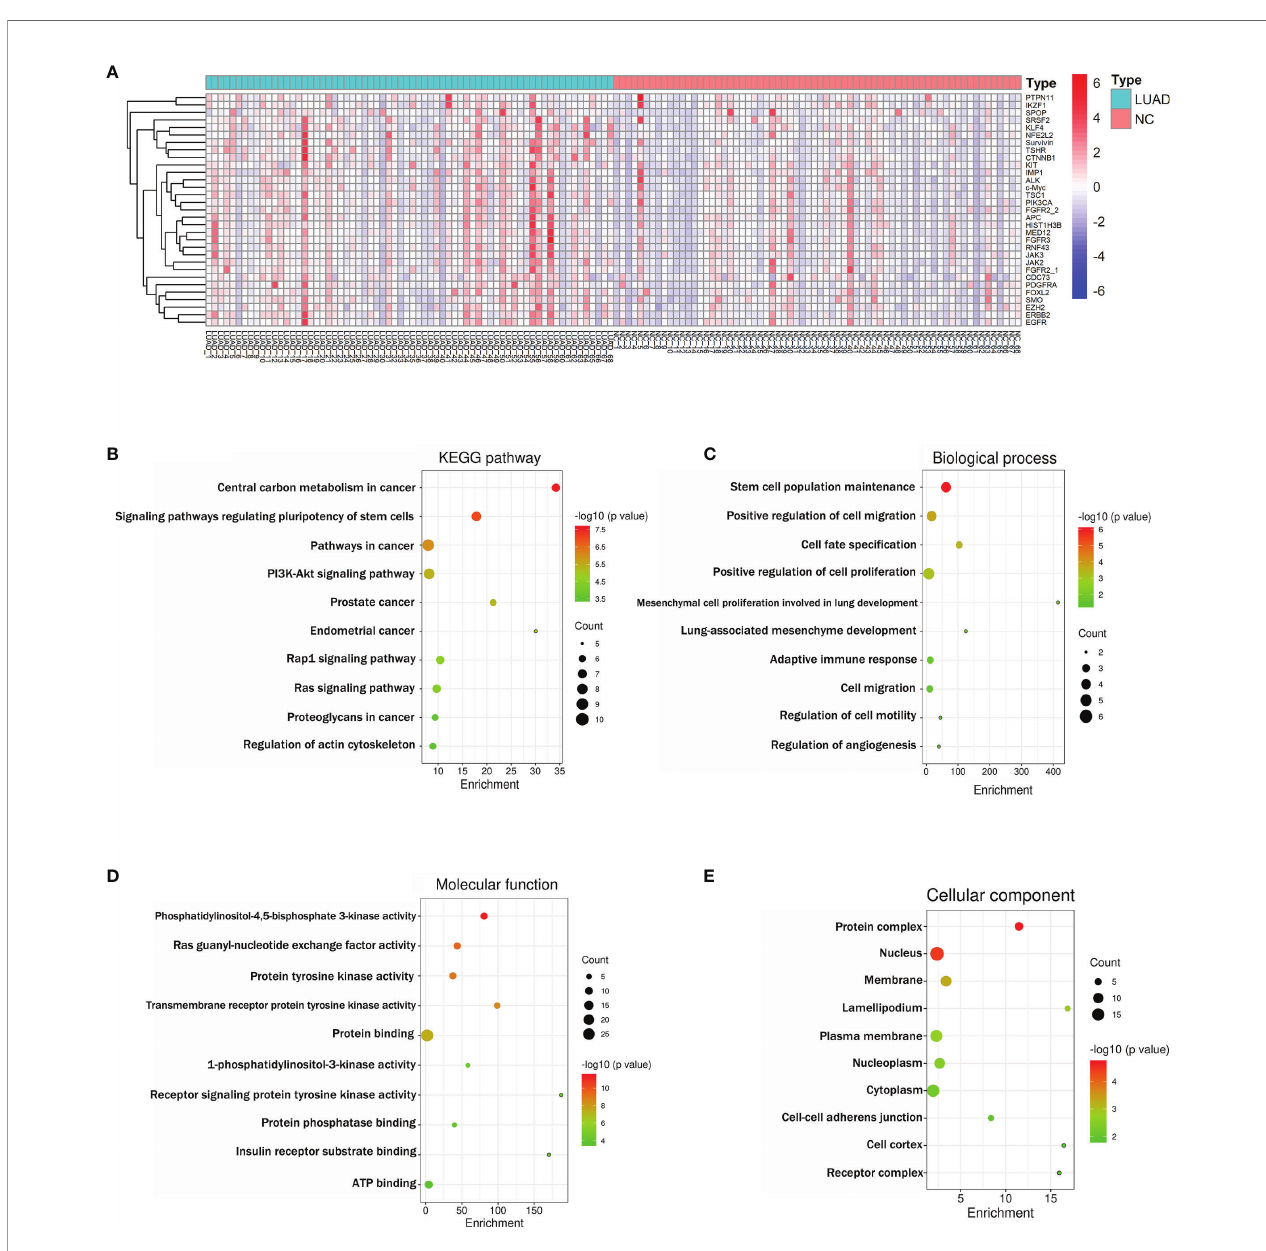
FIGURE 3 | (A) Heatmap of the 31 differently expressed IgM autoantibodies between LUAD and NC. (B) Schematic representation of the 10 KEGG pathways for the 31 differentially abundant IgM autoantibodies in LUAD (all p < 0.001). (C – E) Schematic representation of the GO terms for the 31 differentially abundant IgM autoantibodies in LUAD (all p < 0.05). GO, Gene Ontology; KEGG, Kyoto Encyclopedia of Genes and Genomes; LUAD, lung adenocarcinoma; NC, normal control. Enrichment (fold enrichment) is de fi ned as the ratio of the two proportions. For example, if 10/22 (i.e., 45.5%) of the input genes involved in “ pathways in cancer ” and the background information is 393/6,879 genes (i.e., 5.7%) associating with “ pathways in cancer ” , the fold enrichment is roughly 8